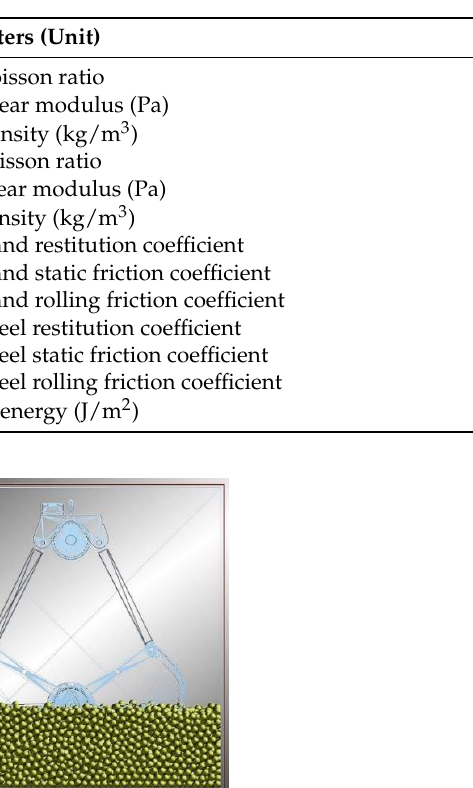
Table 1. DEM parameters used in simulations.